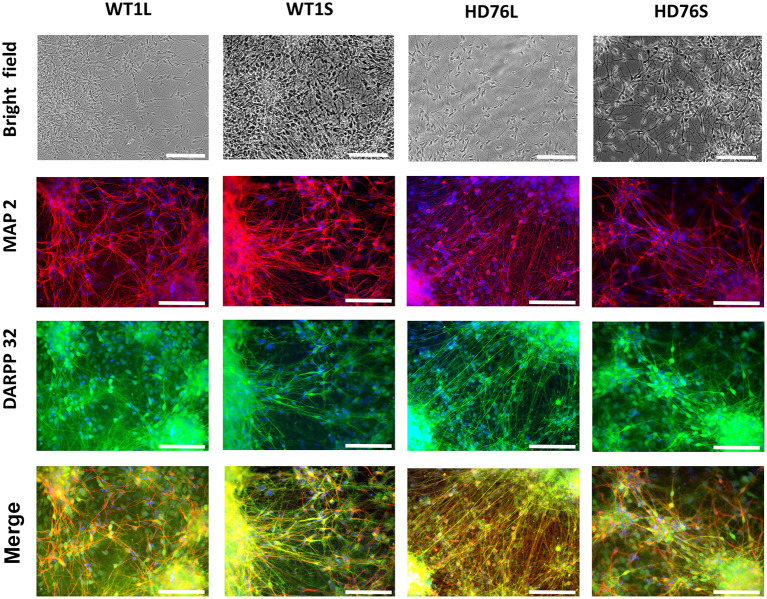
HD76 and WT iPSCs-derived neurons analysis. Representative images of neurons in the bright field (photo of the cells in culture) and immunostained for MAP2 (red), DARPP-32 (green) and merge of MAP2 and DARPP32 counterstained with DAPI (blue). HD76L and HD76S – juvenile HD-specific neuronal cell lines differentiated from iPSCs obtained by lentivirus and Sendai virus approaches, respectively; WT1L and WT1S – wild type neuronal cell lines differentiated from iPSCs obtained by Lentivirus and Sendai virus approaches, respectively. The cell lines are also represented in Supplementary Table 1. Scale bar 100 μm.